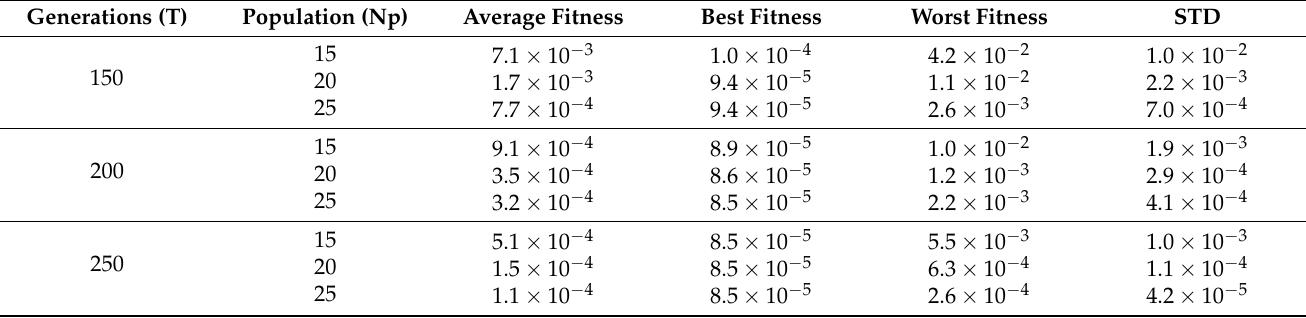
Table 2. DMOA analysis w.r.t. generation numbers and population sizes at 0.01 noise variance.